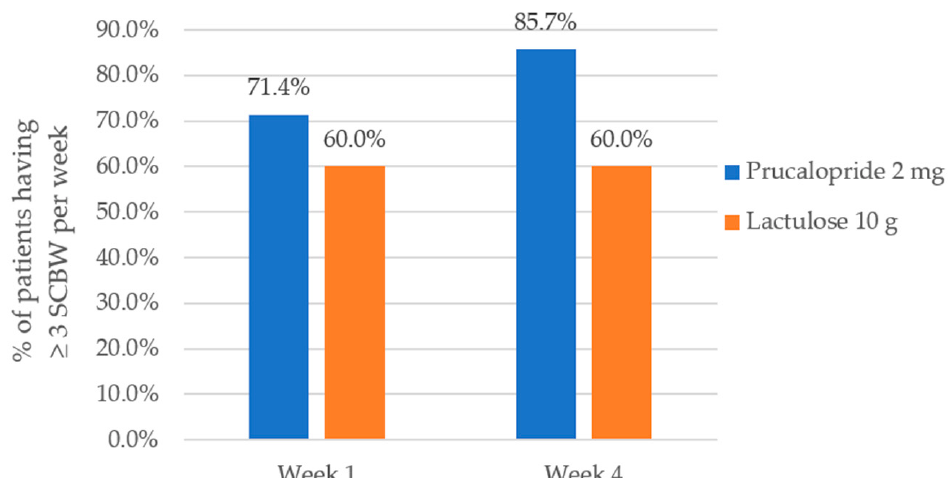
Figure 2. Effect of treatment on the primary endpoint (efficacy). Proportion of patients with ≥ 3 spontaneous complete bowel movement (SCBM) per week at Week 1 and Week 4, in patients treated with Prucalopride 2 mg and Lactulose 10 g. p = 0.360 ( χ 2 value = 0.837) at Week 1 and p = 0.029 ( χ 2 value = 4.794) at Week 4.